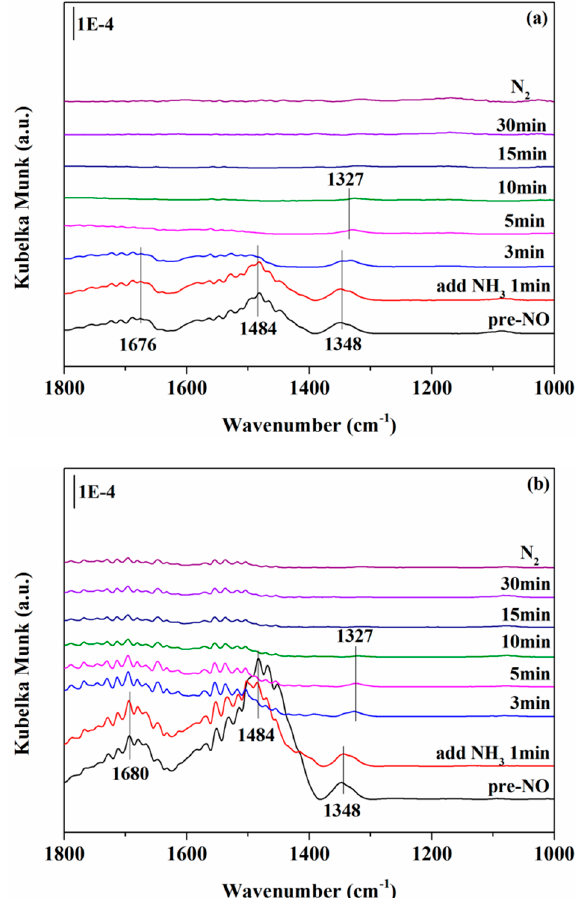
Figure 8. In situ DRIFT spectra of the reaction between NH 3 and adsorbed NO + O 2 species over ( a ) VWTi-S and ( b ) VWCeCuTi-S at 250 °C.